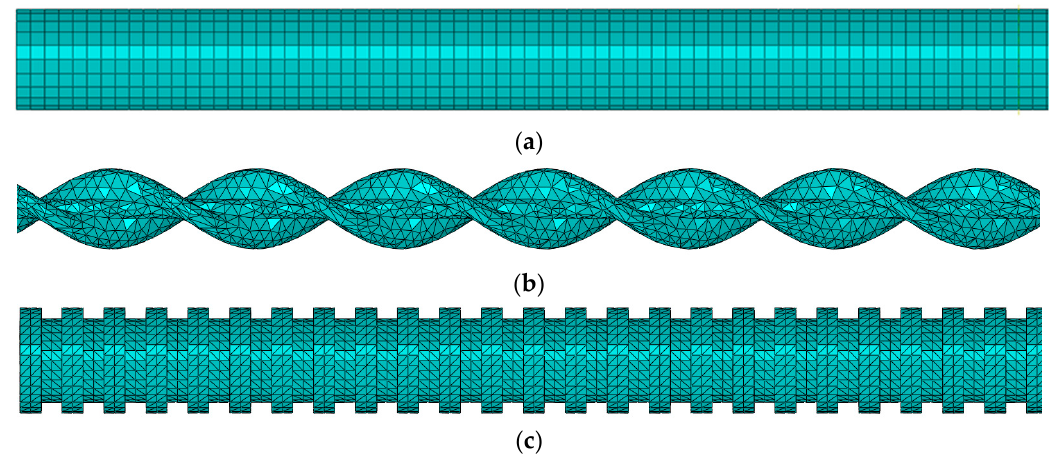
Figure 7. FE models of ( a ) regular bar. ( b ) double-wrapped bar, and ( c ) ribbed bar.